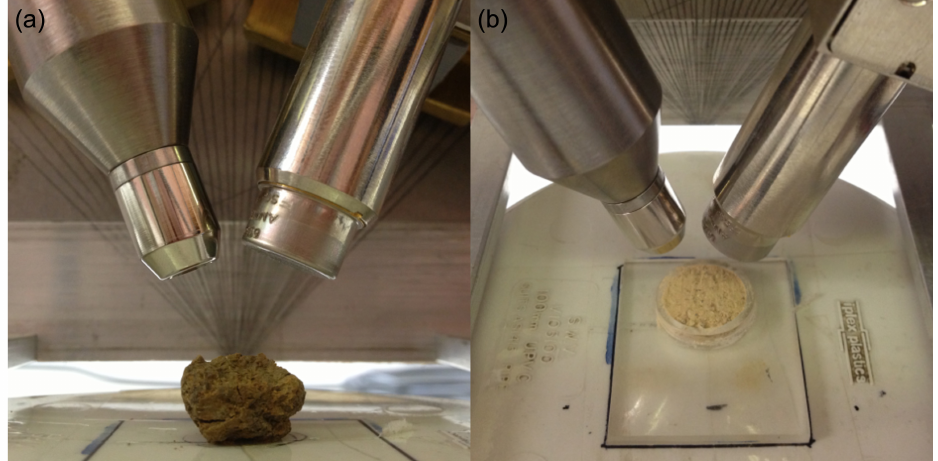
Figure 3. The portable XRF analyzer and spectral measurement for ( a ) natural soil aggregate and ( b ) 1 mm ground soil